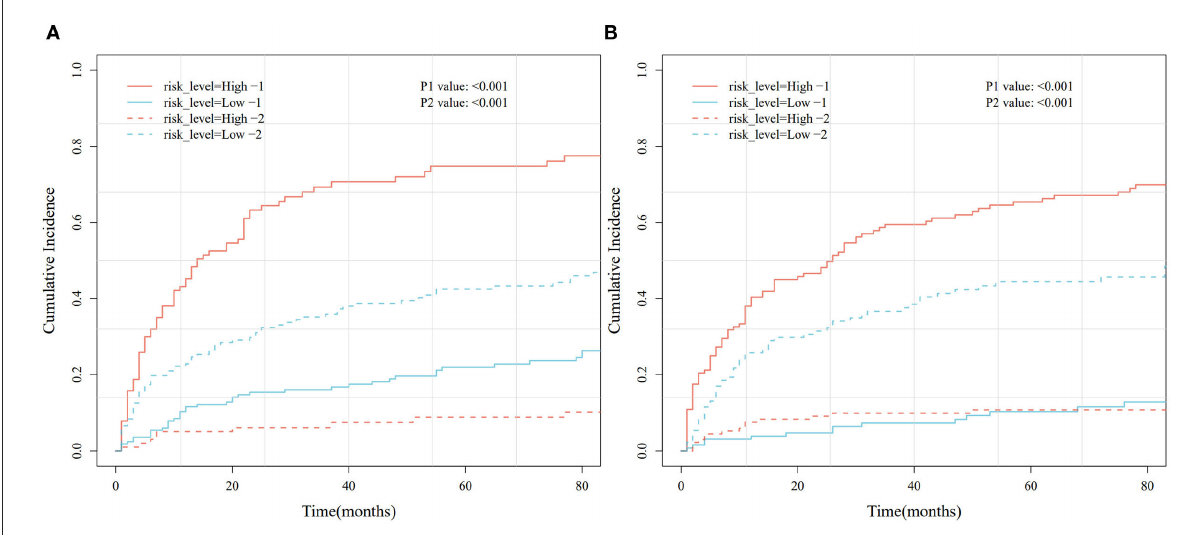
FIGURE6 Cumulative risk curve analysis based on different risk groups generated by the nomogram model in the training and validation sets. (A) Training set. (B) Validation